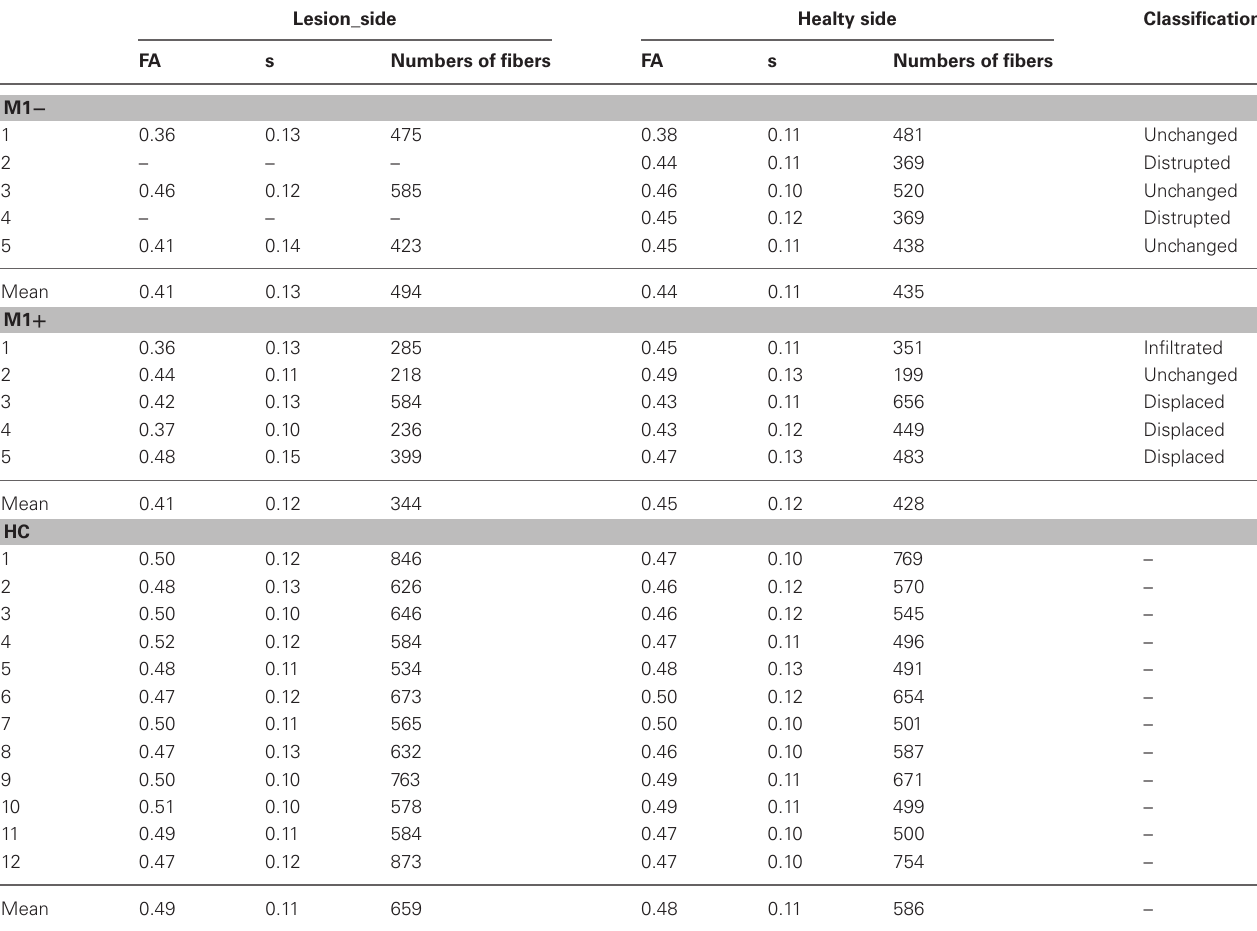
Table 2 | Results of the DTI